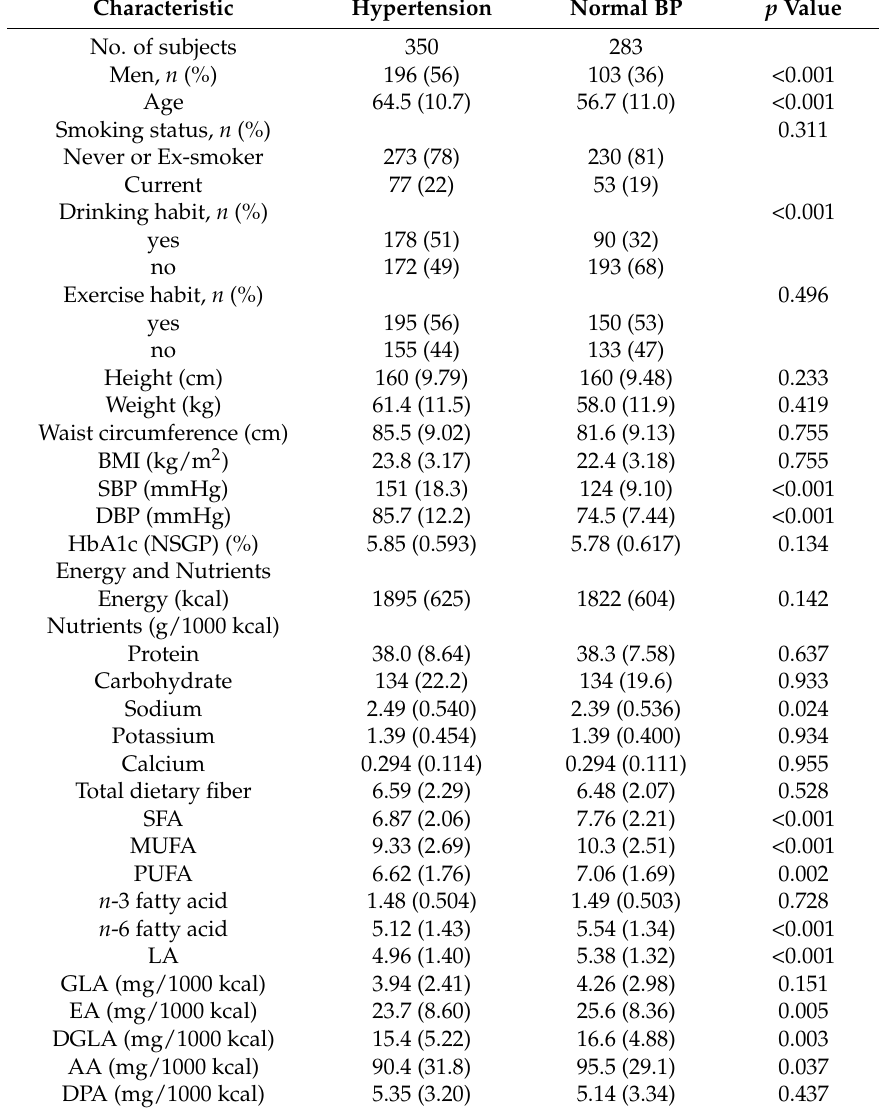
Table 2. Participant characteristics in different blood pressure